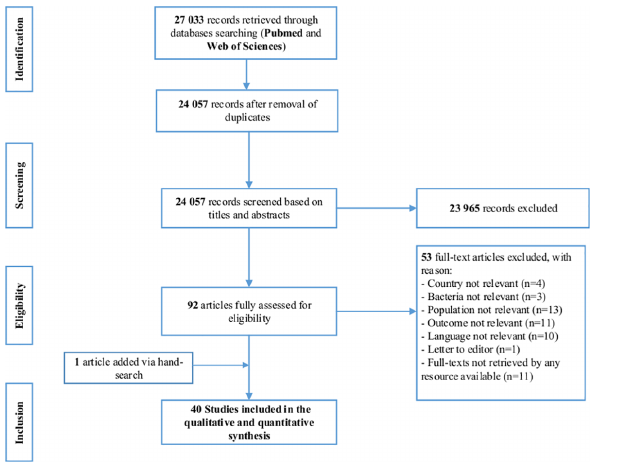
Fig 1. Prisma Flow-chart illustrating the study selection